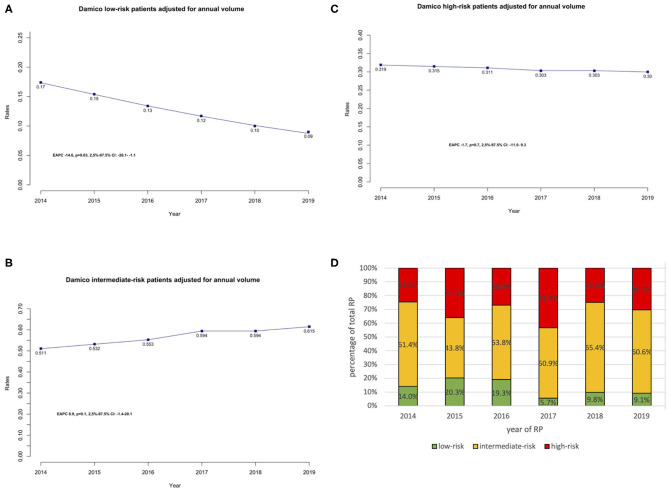
(A–C) Trends of performed RP stratified regarding D'Amico low-risk constellation (A: low-risk, B: intermediate-risk, C: high-risk D'Amico classification), adjusted for the annual surgical volume. EAPC was calculated for each cohort separately. (D) Proportion of 528 patients stratified according to D'Amico risk groups (low, intermediate, and high risk) shown as a percentage of the total number of cases per year.